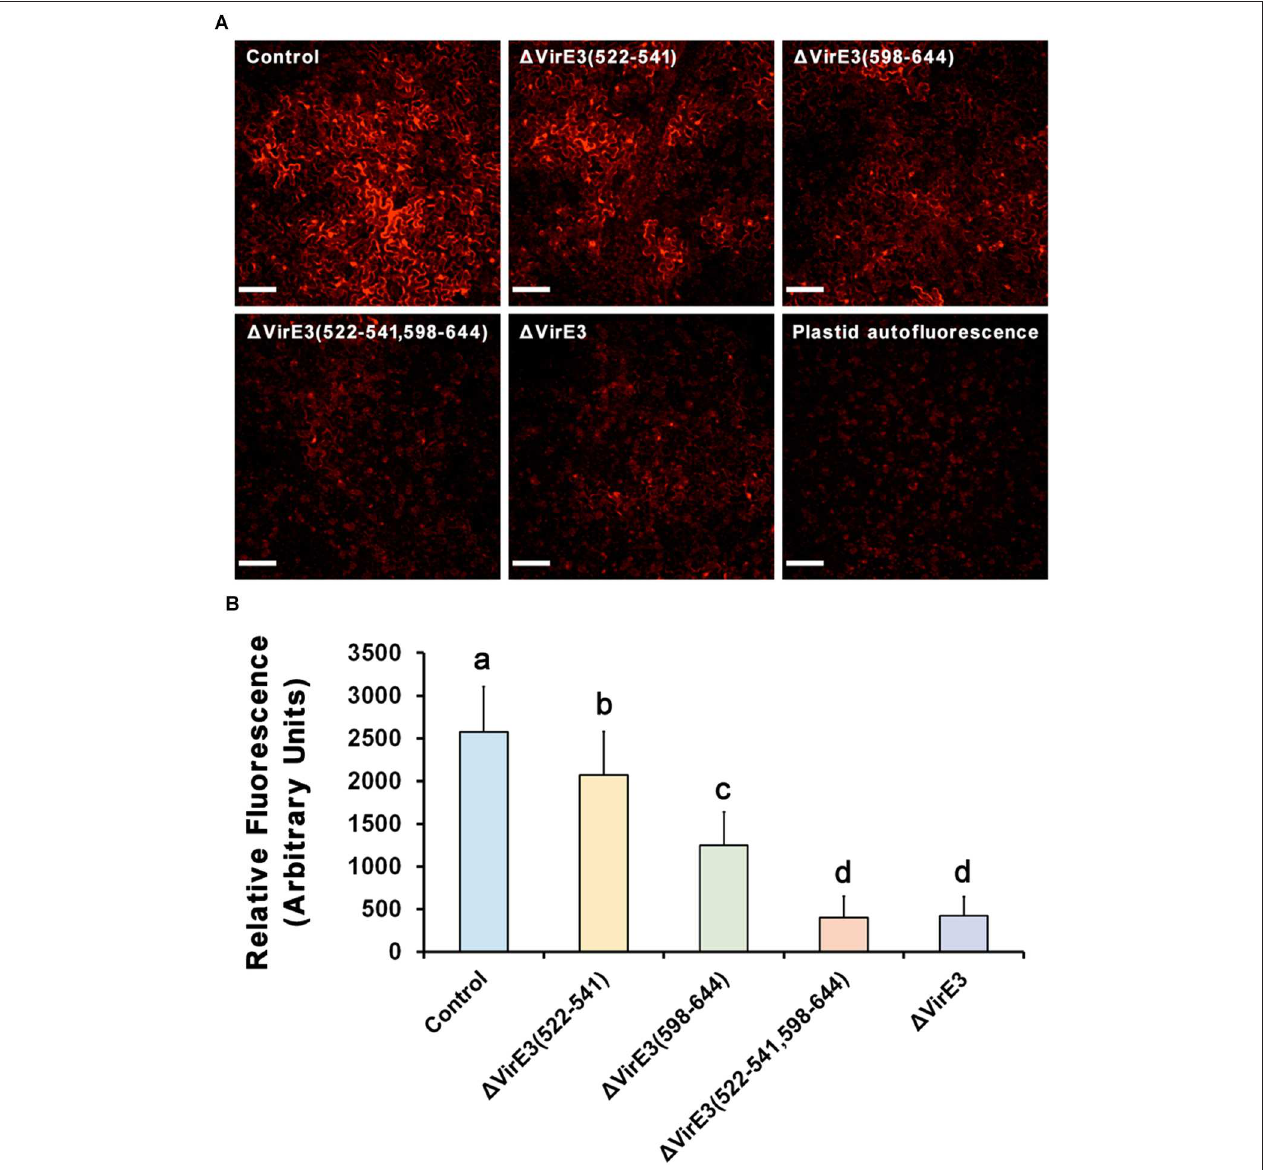
FIGURE 6 | Deletions of VirE2-interacting domains of VirE3 attenuate the transient transformation efficiency of A. tumefaciens . (A) Wild-type N. benthamiana leaves were infiltrated with A. tumefaciens EHA105 (control), EHA105 1 VirE3(522-541), EHA105 1 VirE3(598-644), EHA105 1 VirE3(522-541,598-644) or EHA105 1 VirE3 containing a binary plasmid pmC13-Reverse (expressing free mCherry under the CaMV 35S promoter on T-DNA). Scale bars, 100 µ m. (B) The fluorescence intensity of transiently expressed mCherry was measured in each image. Data are presented as means ± SDs of n = 30 independent samples. p <